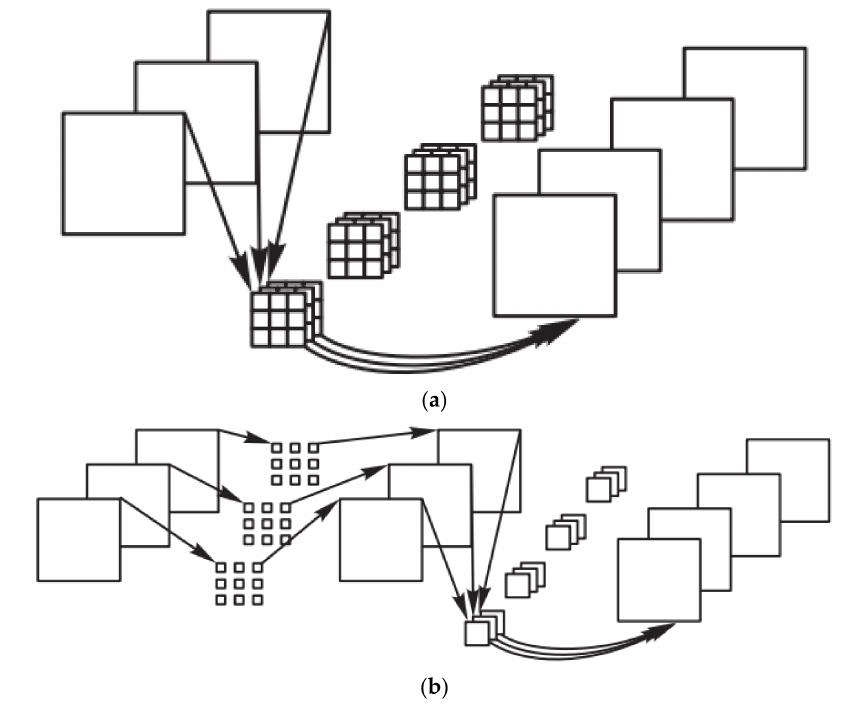
Figure 3. The comparison of the standard convolution process and depthwise separable convolution process. ( a ) Standard convolution process; ( b ) depthwise separable convolution process with